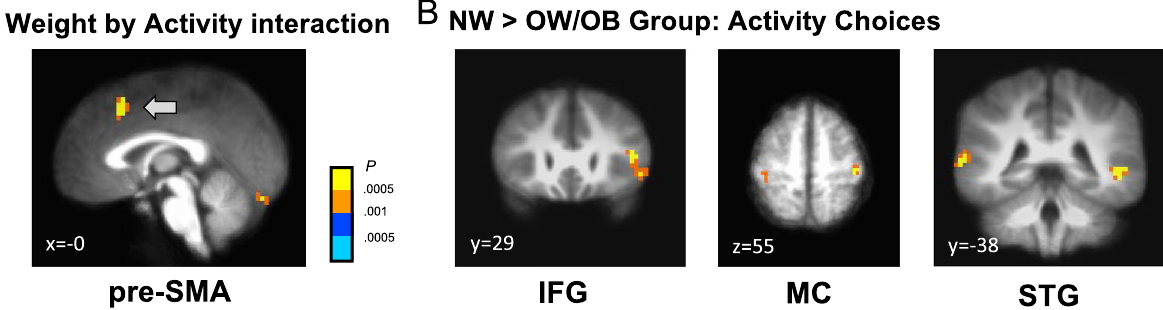
Figure 5. ( A ) Weight by activity group interaction effect was found in the pre-SMA. ( B ) Normal weight group ( n = 21) compared to overweight/obesity group ( n = 17) showed stronger IFG, motor cortex, and STG activations during activity choices. The images are threshold at p < 0.05 corrected with cluster size